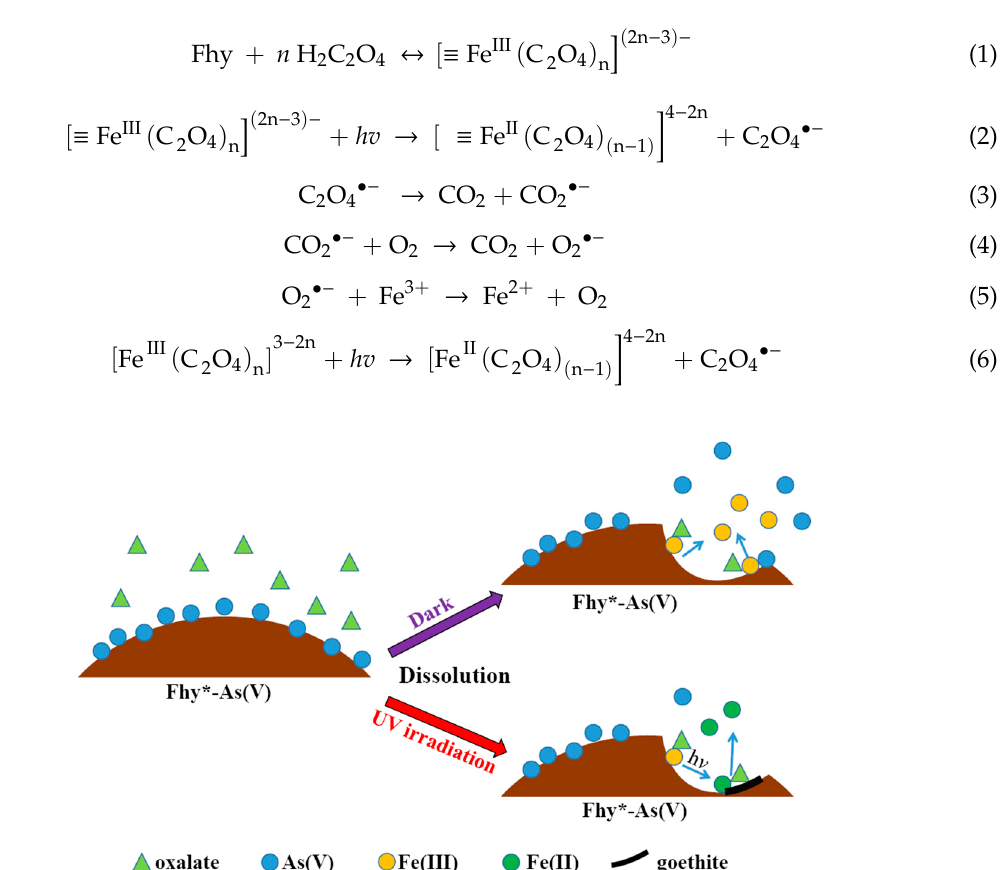
Figure 9. Proposed mechanisms of Fhy photodissolution and As(V) migration in Fhy*-As(V).